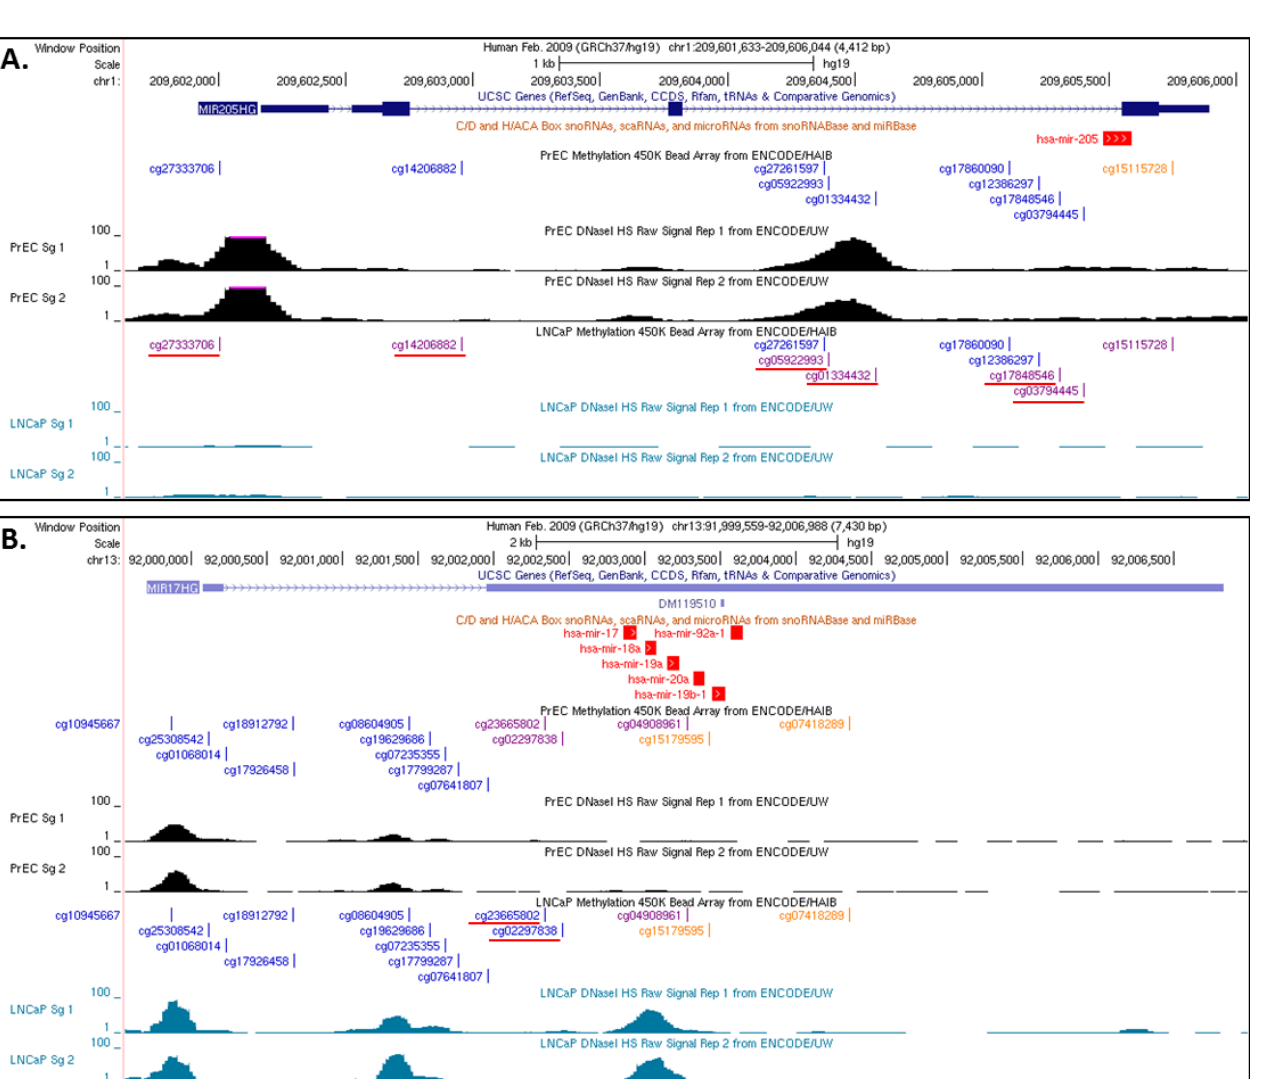
Figure 3. UCSC genome browser tracks showing CpG methylation and DNase I cleavage status around miRNAs. Top panel track shows the genomic location of the miRNA. Middle track shows the CpGs in genomic fragment and color of each CpG represent the beta values ( ENCODE description—Orange, beta value equal to or greater than 0.6 was considered fully methylated; Purple, Beta values between 0.2 and 0.6 were considered to be partially methylated; Blue, beta value equal to or less than 0.2 was considered to be fully unmethylated). Bottom panel shows the DNaseI sensitivity measured in PrEC (black) and LNCaP (blue). DNaseI hypersensitive sites shown as peaks suggest accessible chromatin; conversely no DNaseI hypersensitive sites suggest closed chromatin. ( A ) Shows the status of miR-205. Most of the CpGs around miR-205 are partially methylated in LNCaP and un- methylated in PrEC. Supportively, DNaseI sensitivity shows open areas in PrEC cells and closed chromatin in LNCaP and. ( B ) Shows the status of a miR-17-92 cluster. Two CpGs around this cluster are partially methylated in PrEC cells and un-methylated in LNCaP. Supportively, DNaseI sensitivity shows open chromatin in LNCaP and closed in PrEC cells. Differentially methylated CpGs are